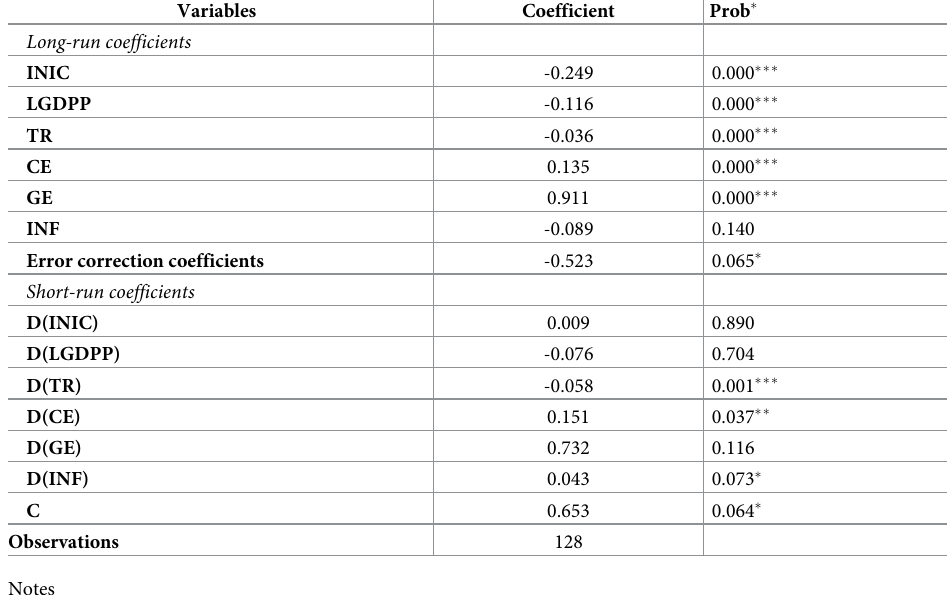
Table 8. Empirical findings on the effects of national intellectual capital on shadow economy using the pooled mean group